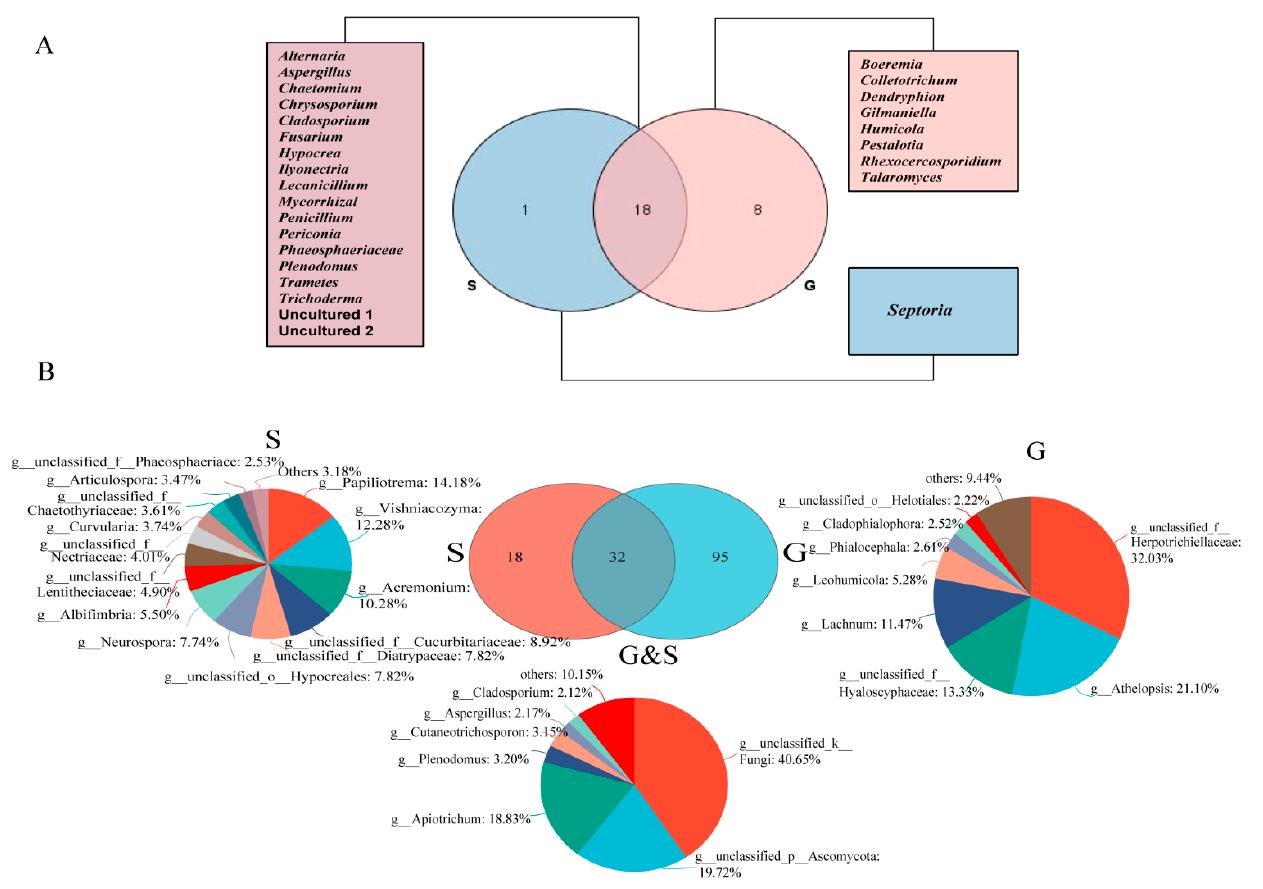
Figure 1. The unique and shared endophytic fungi from different tissues of S. chamaejasme at genus level. ( A ): culture-dependent endophytic fungi; ( B ): culture-independent endophytic fungi. The fungi with a percentage below 2% were grouped as ‘others’. S = Shoot; G = Root; G & S = Root & Shoot.